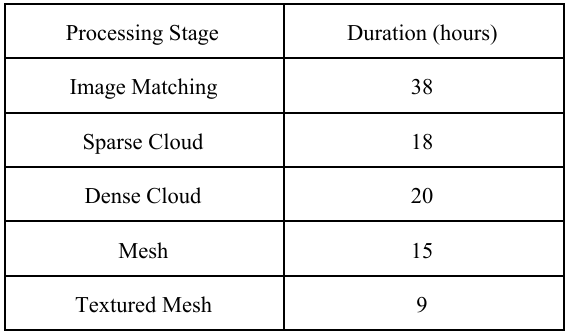
Table 4. Processing time per stage